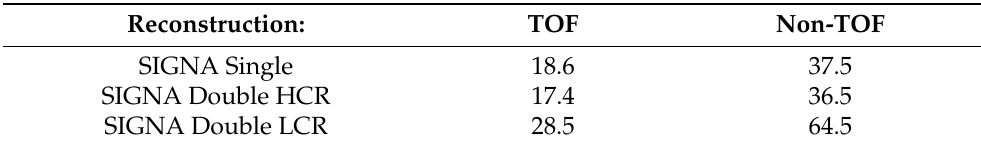
Table 8. 1 pixel scale Background Variability [%] at the CR matching update numbers for the different acquisitions.